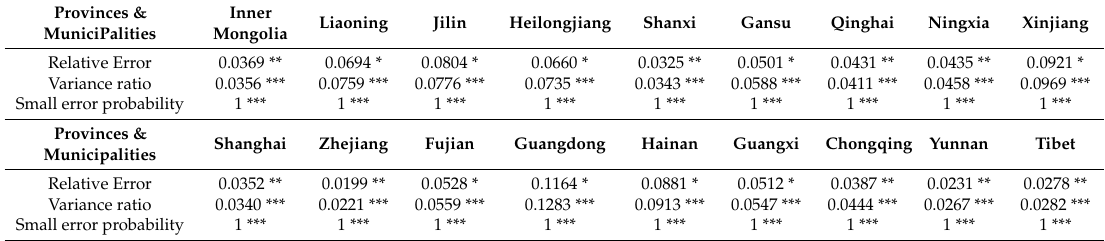
Table 5. Average relative error, variance ratio, and small error probability of the Grey Prediction Model.